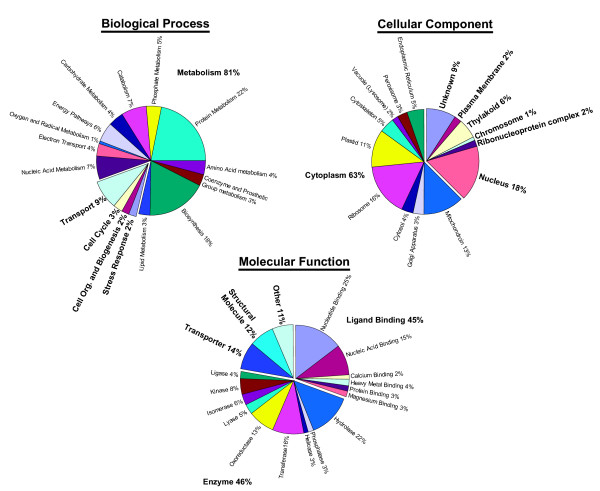
GO category assignment of A. tamarense ESTs. Classification of 1,203 A. tamarense ESTs into the GO categories.